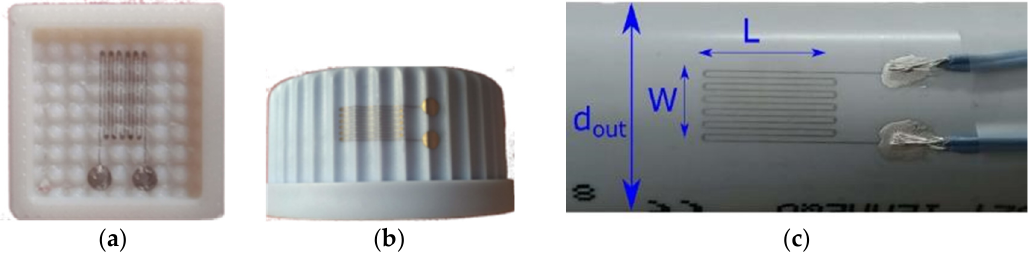
Figure 6. Example of printed serpentine devices with the proposed method. Printed device: ( a ) on different 3D surfaces 2.4 cm × 2.4; ( b ) on a 5.6 cm diameter cap; ( c ) on a PVC conduit of 20 mm diameter (d out ). Strain gauge dimensions: active gauge length (L) is 10 mm and the gauge width (W) is 5.5 mm.